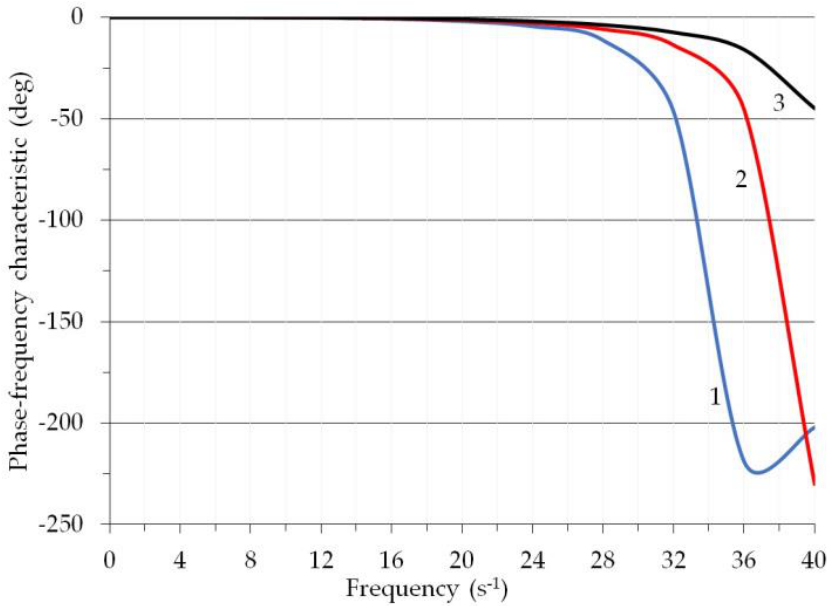
Figure 6. Phase–frequency characteristics of the dynamic system during the performance of the Figure 6. Phase – frequency characteristics of the dynamic system during the performance of the dis- disturbance at different values of the parameter L : curve 1, L = 3.8 m; curve 2, L = 4.3 m; curve 3, turbance at different values of the parameter 𝐿 : curve 1, L = 3.8 m; curve 2, L = 4.3 m; curve 3, L = 4.8 L = 4.8 m